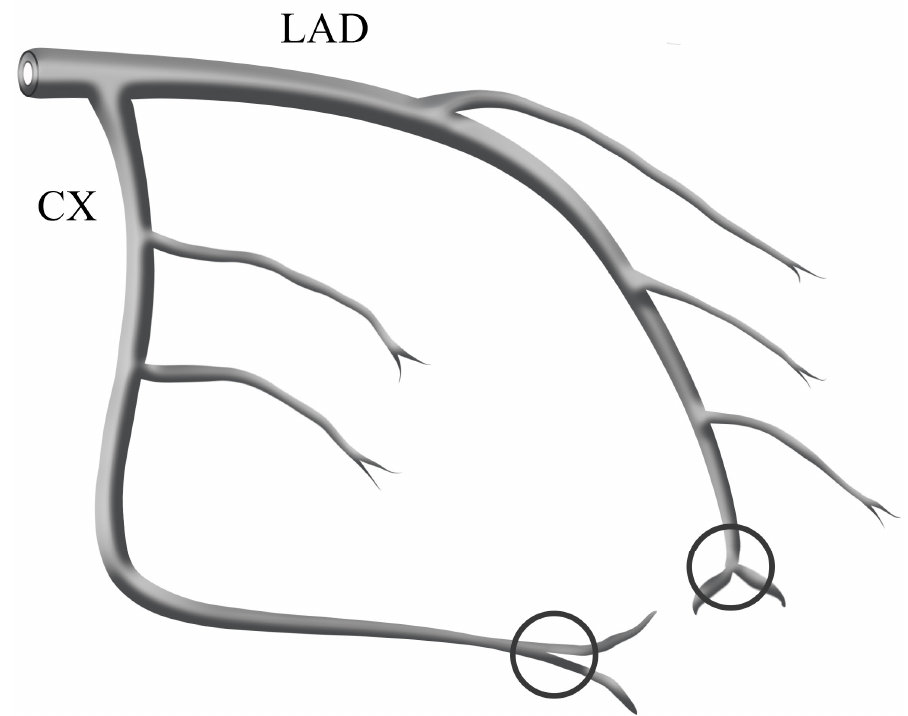
Figure 1. The schematic diagram shows distal landmark points for LAD and Cx. These include the distal bifurcation of the LAD, also known as the ‘moustache’, as well as the distal branch of the lateral left ventricular wall artery farthest from the coronary ostium for the Cx.